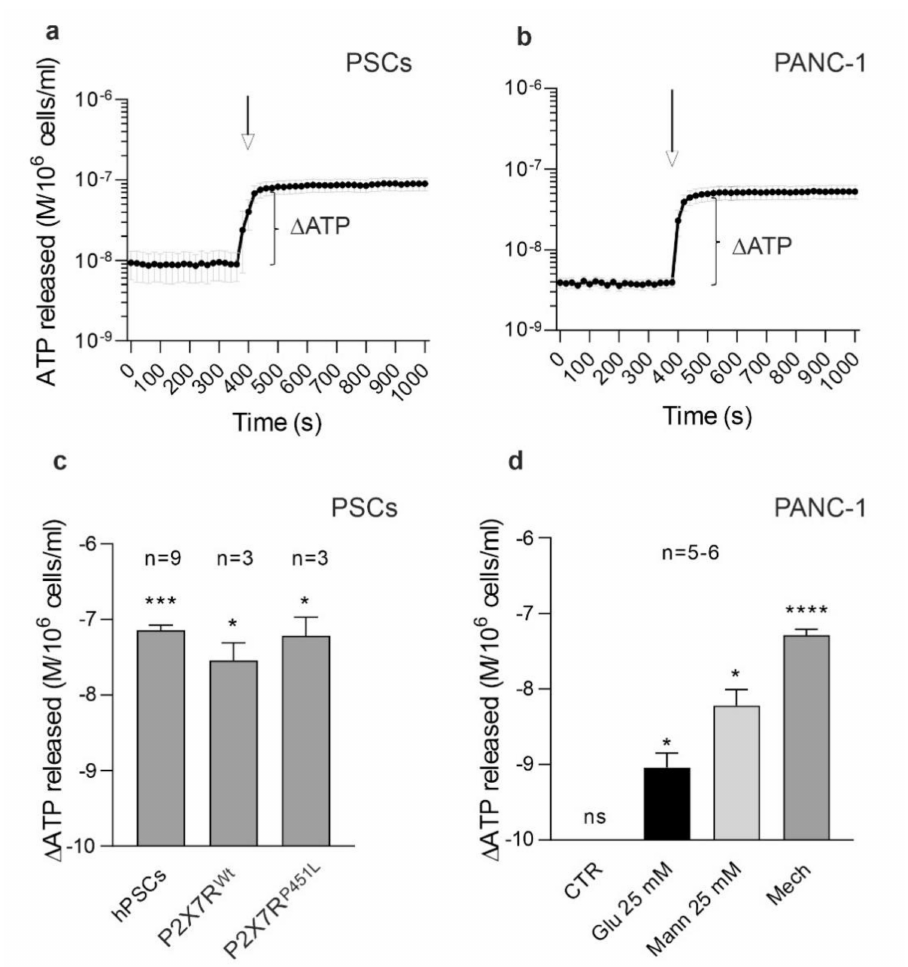
Figure 6. ATP release in PSCs and PANC-1. ( a , b ) Time course of ATP release in PSCs and PANC-1 cells after mechanical stimulation by injection pump showing the basal and stimulated ATP release (see methods). ( c ) The ATP release in response to the mechanical stimulus in the three types of PSCs. ATP quantification is expressed as ∆ ATP (M/10 6 cells/ml, log axis) from basal to stimulated condition. ( d ) Effect of increasing substrate glucose from 5 to 25 mM (Glu 25 mM) or cell volume effects due to mannitol (Mann 25 mM) (manual addition) or mechanical stimulation (Mech) (pump injection). ( c , d ) Data were log transformed and maximal ATP release compared to the basal ATP, as depicted in ( a , b ), was tested in paired t -test analysis for each condition and significance is indicated as * p < 0.05, *** p < 0.001, **** p < 0.0001, ns